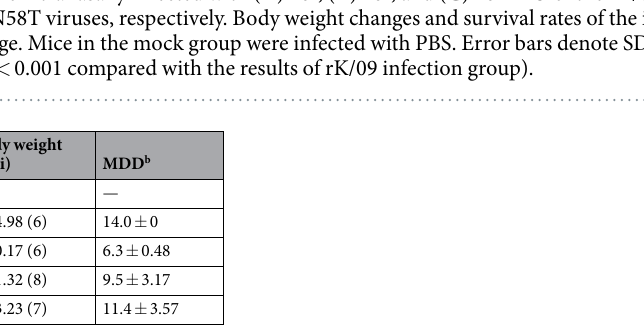
Table 3. Pathological findings from the mice infected with the K/09 and its NA stalk mutant viruses. a,b Please see footnotes in Table